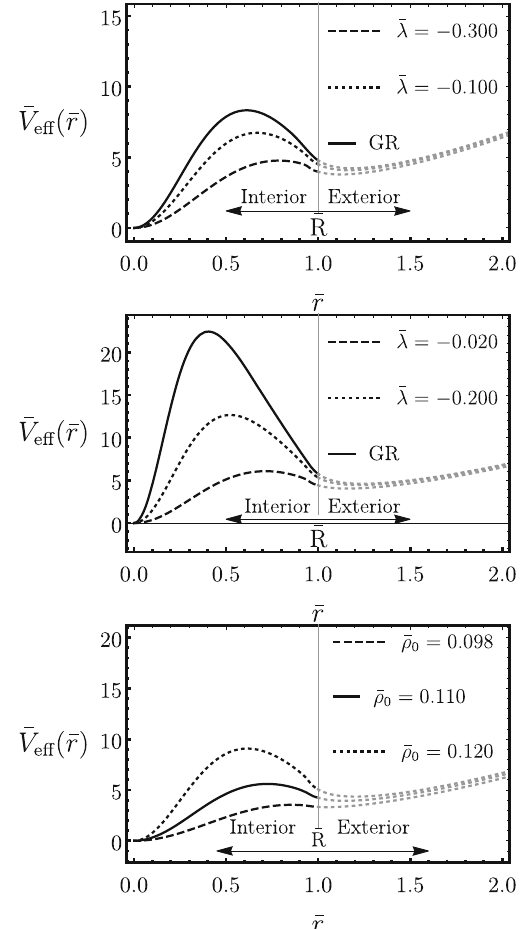
Fig. 13 ¯ V eff as a function of ¯ r for different values of ¯ λ < 0, and ¯ ρ = 0 . 110 (upper panel), ¯ ρ = 0 . 115 (center panel), and for different 0 0 values of ¯ ρ 0 and ¯ λ = − 0 . 12 (lower